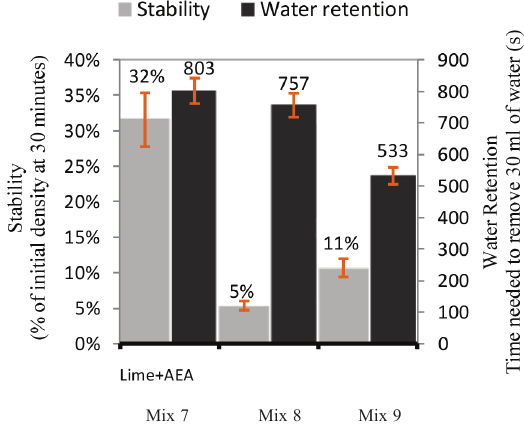
Fig. 3(c). Effect of pozzolans and AEA on stability and water retention of different grout